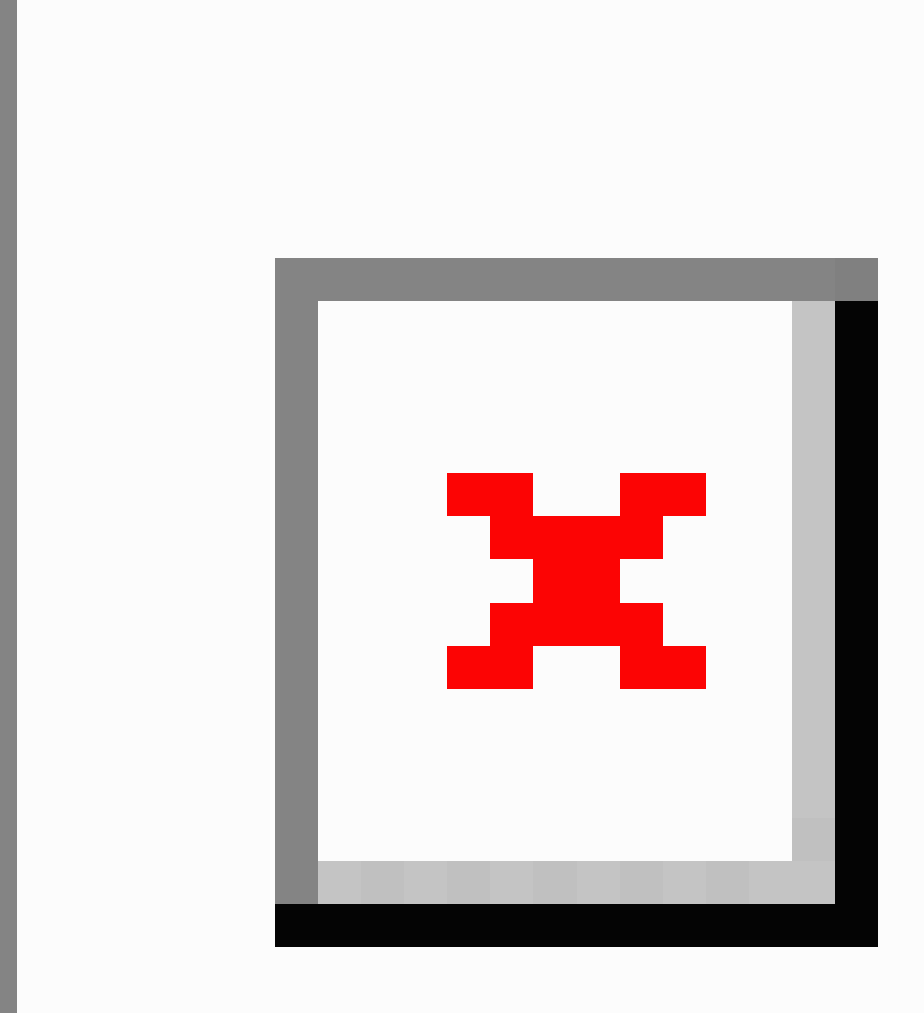
Figure 1. Flowchart of participant